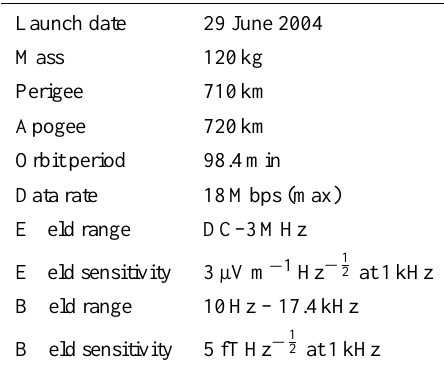
Table 1. Data for the DEMETER satellite (CNES,